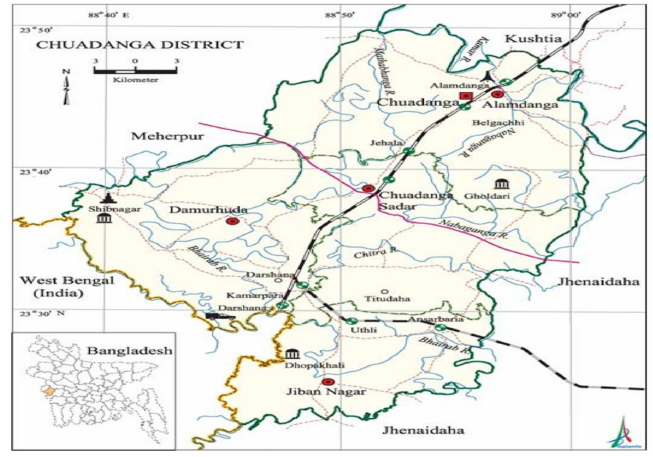
Figure 1. Map of Chuadanga District showing Chuadanga sadar and Damurhuda upazila in